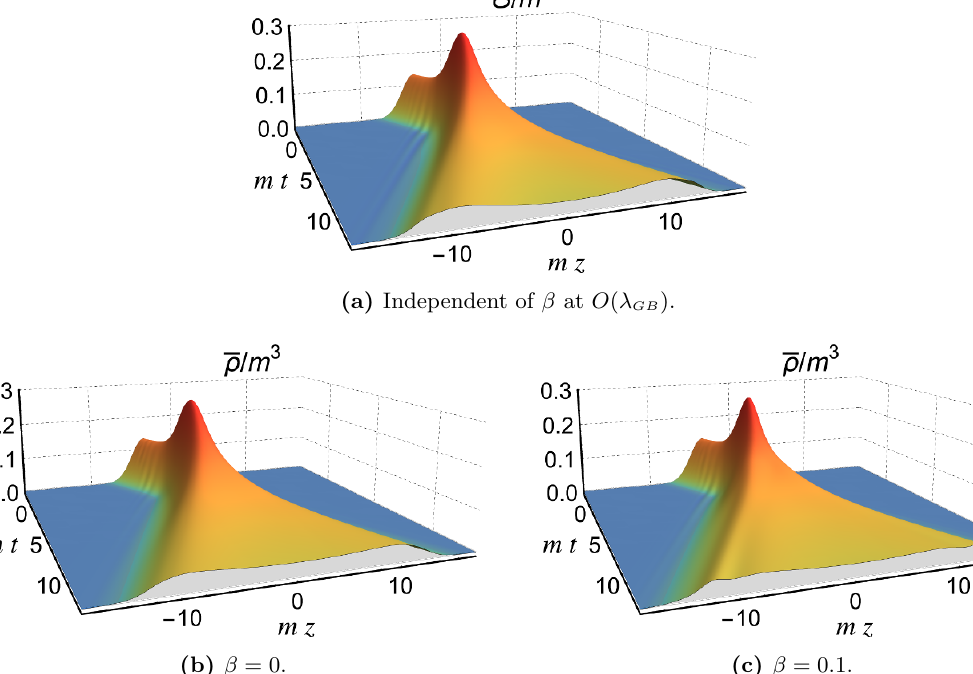
Figure 1 . Spacetime dynamics of the energy density (top panel) and baryon number density (bottom panels) in collisions of thick sheets (width w = 1 : 5 =m ) at (cid:21) = 0 in the (cid:15) = 0 limit (no GB back-reaction of the baryon number on the energy density). The two lower panels show the time evolution of the baryon number density at two di(cid:11)erent values of (cid:12) . In each of the three panels, the horizontal axes are the time t and the spatial coordinate z along which the incident sheets are moving, in both cases measured in units of m (cid:0) 1 . The energy and baryon number density (measured in units of m 4 and m 3 respectively) peak around z = t = 0, the spacetime point at which the collision is centered. At late times, we see the plasma, carrying both energy density and baryon density, extending between the two light-cones. Although it is not visible by virtue of the perspective we have chosen, at early times before the collision there is nothing between the incident